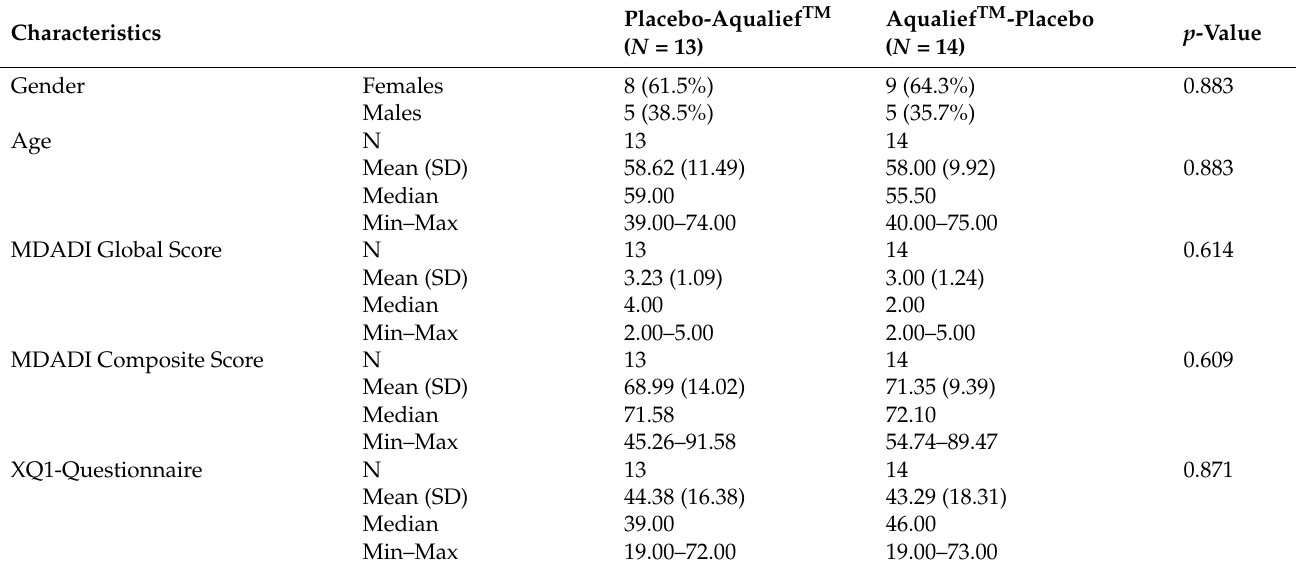
Table 2. Demographics and Treatment Details of the modified ITT